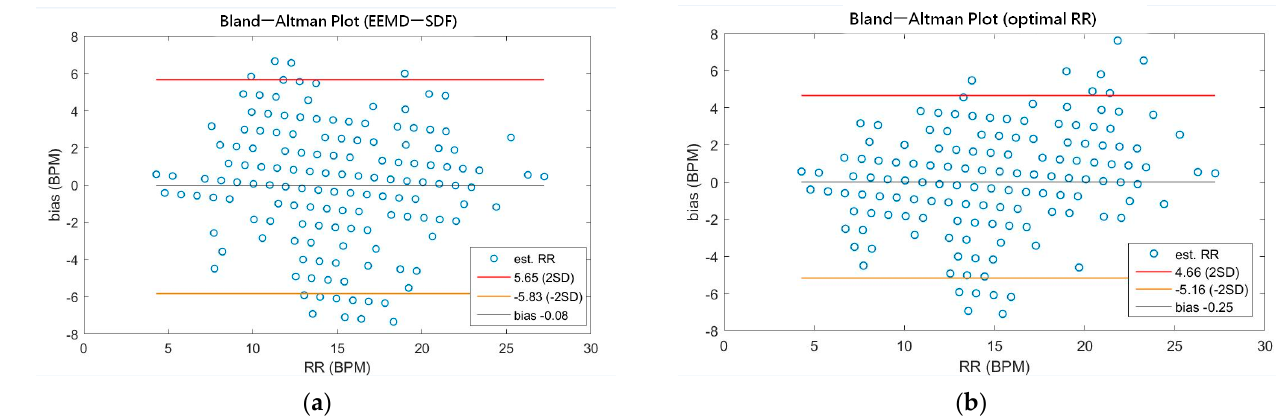
Figure 7. ( a ) The Bland-Altman plot of the estimated RR using EEMD-SDF; ( b ) the Bland-Altman plot of the optimal RR.